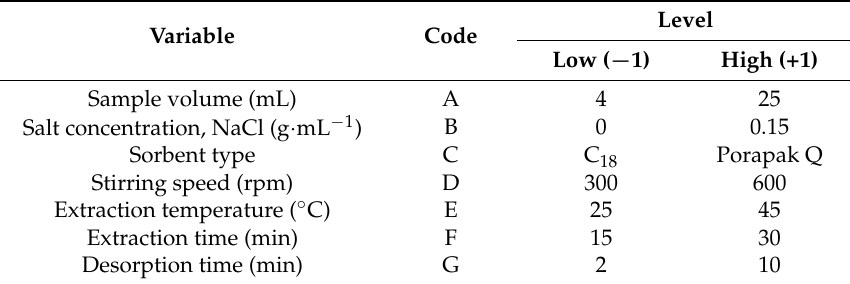
Table 1. Variables and levels used for fractional factorial design 2 7–3 .